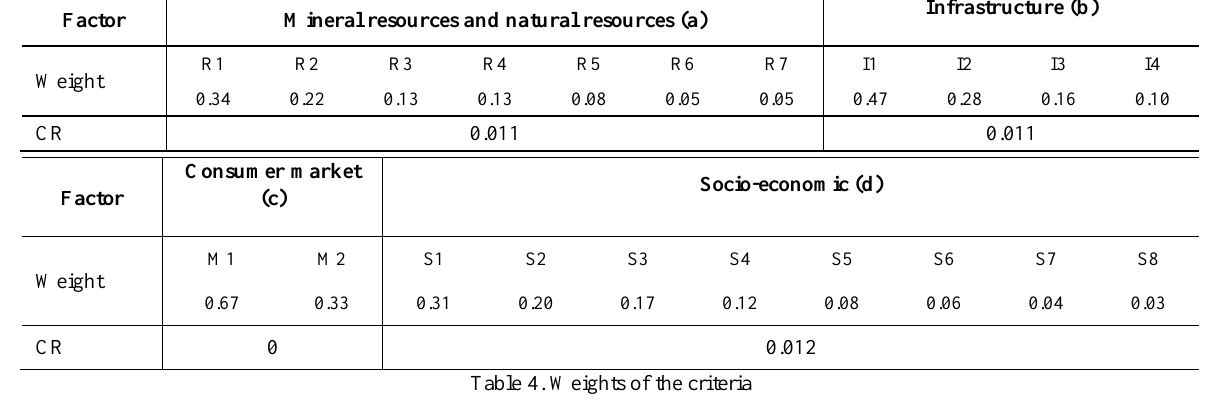
Table 4. Weights of the criteria